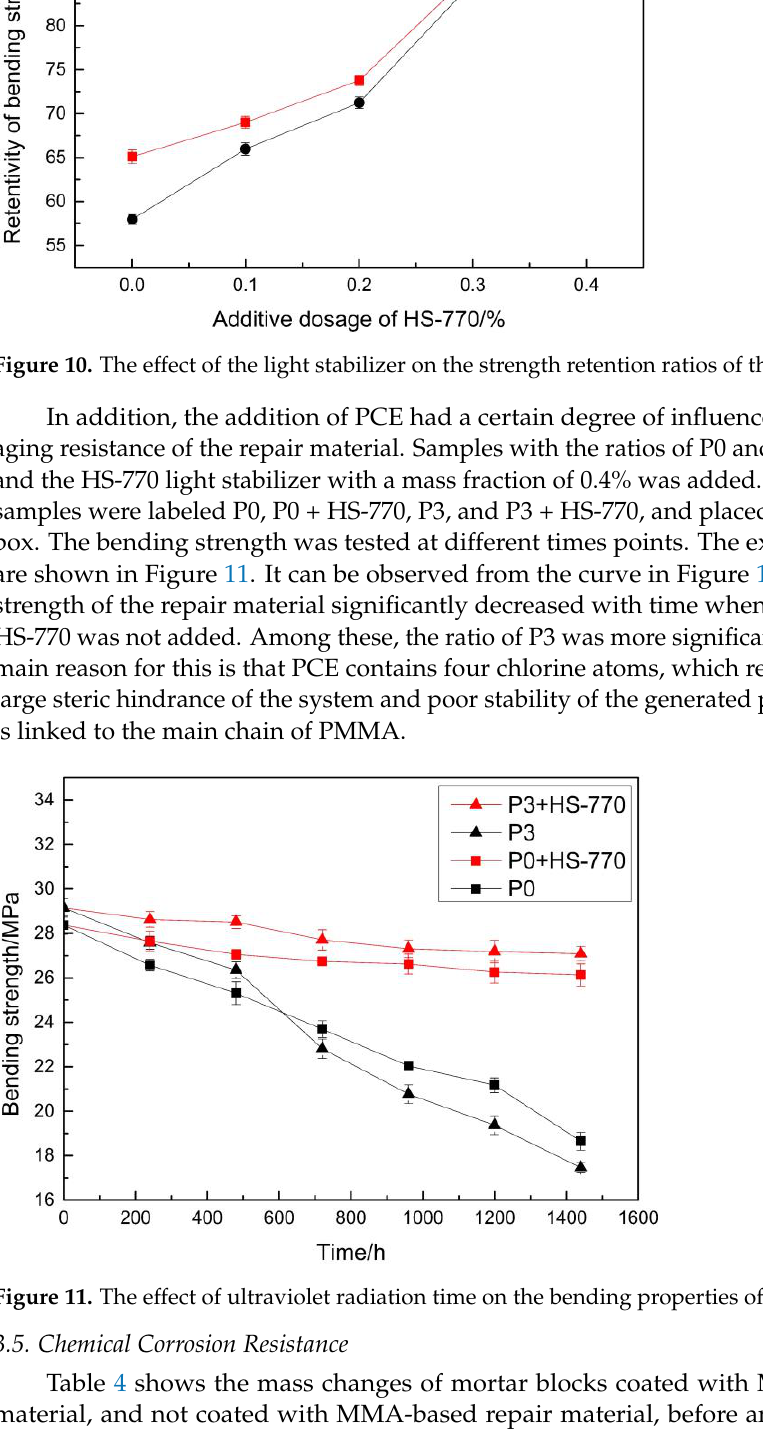
Figure 9. The effect of HS-770 content on bending strength.